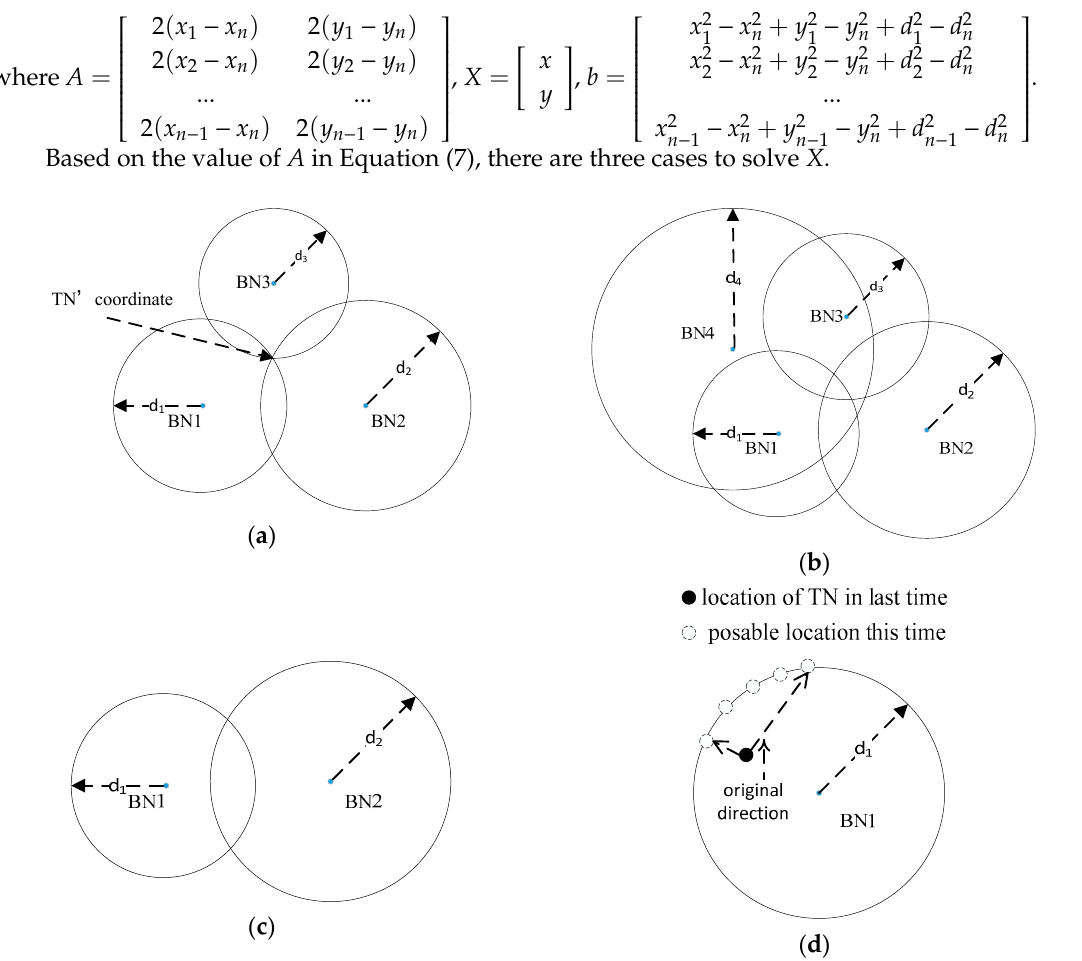
Figure 3. Tag node (TN) localization with different situations: ( a ) An ideal model with three beacon nodes (BNs); ( b ) real situation with ranging error; ( c ) localization with two BNs; ( d ) only one single BN completes the ranging step.